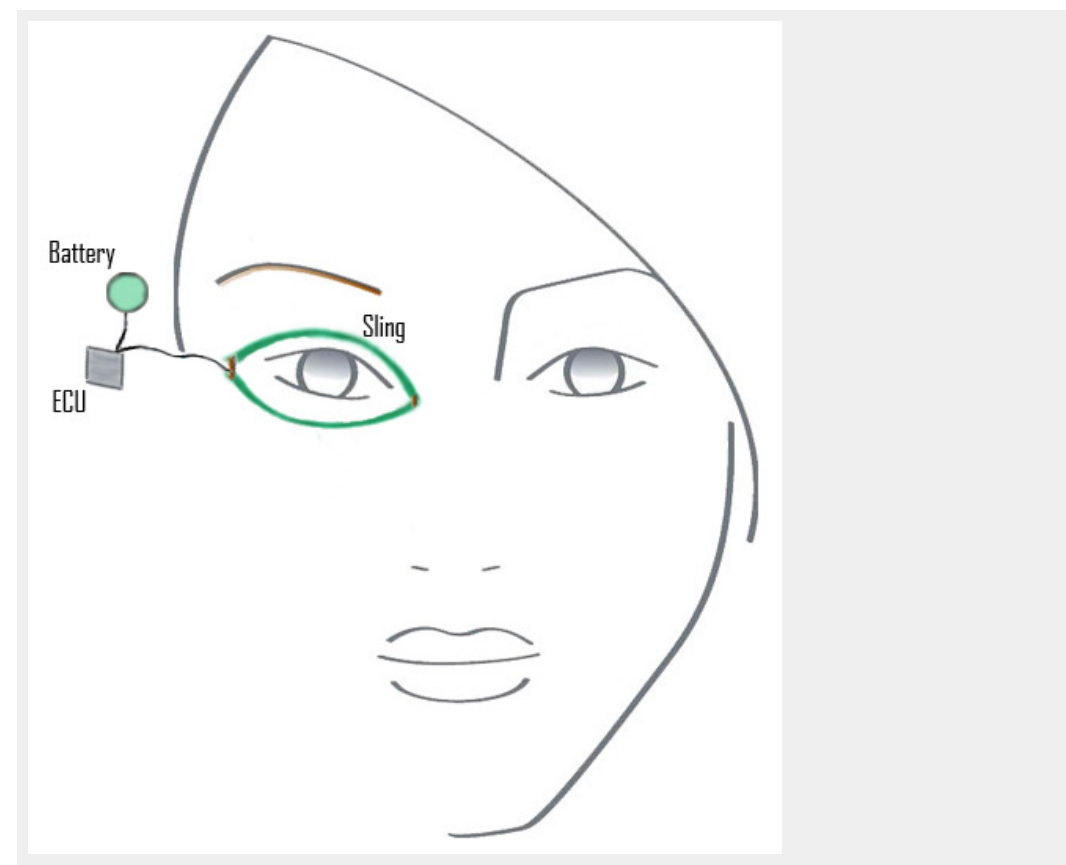
Illustration of a left eyelid sling that is attached to the electroactive polymer artificial muscle device (EPA) after passing through an interpolation unit is implanted in the lateral orbital wall (note screw fixation). The power supply and artificial muscle are implanted in the temporal fossa. Conceptually, when the normal right eyelid blinks, the electrical sensor (green) sends a signal to the battery to activate the